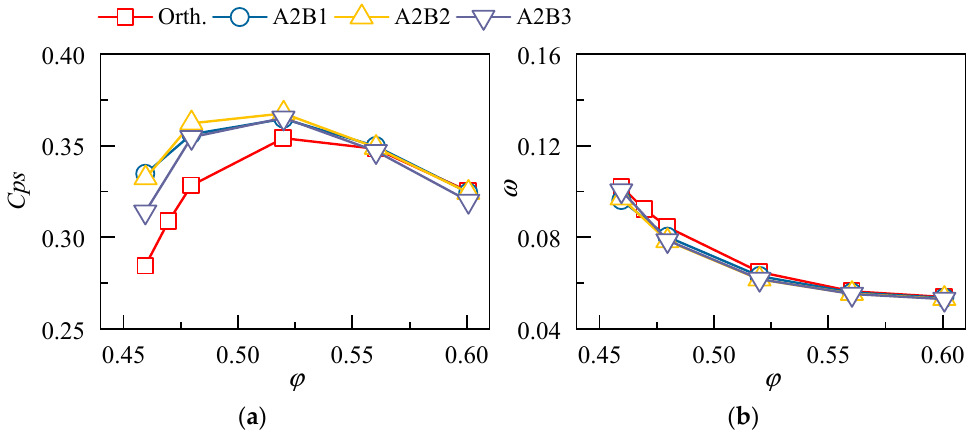
Figure 10. Pressure rise and loss characteristics for the stator with different sweep angles. ( a ) Pressure rise and ( b ) loss.